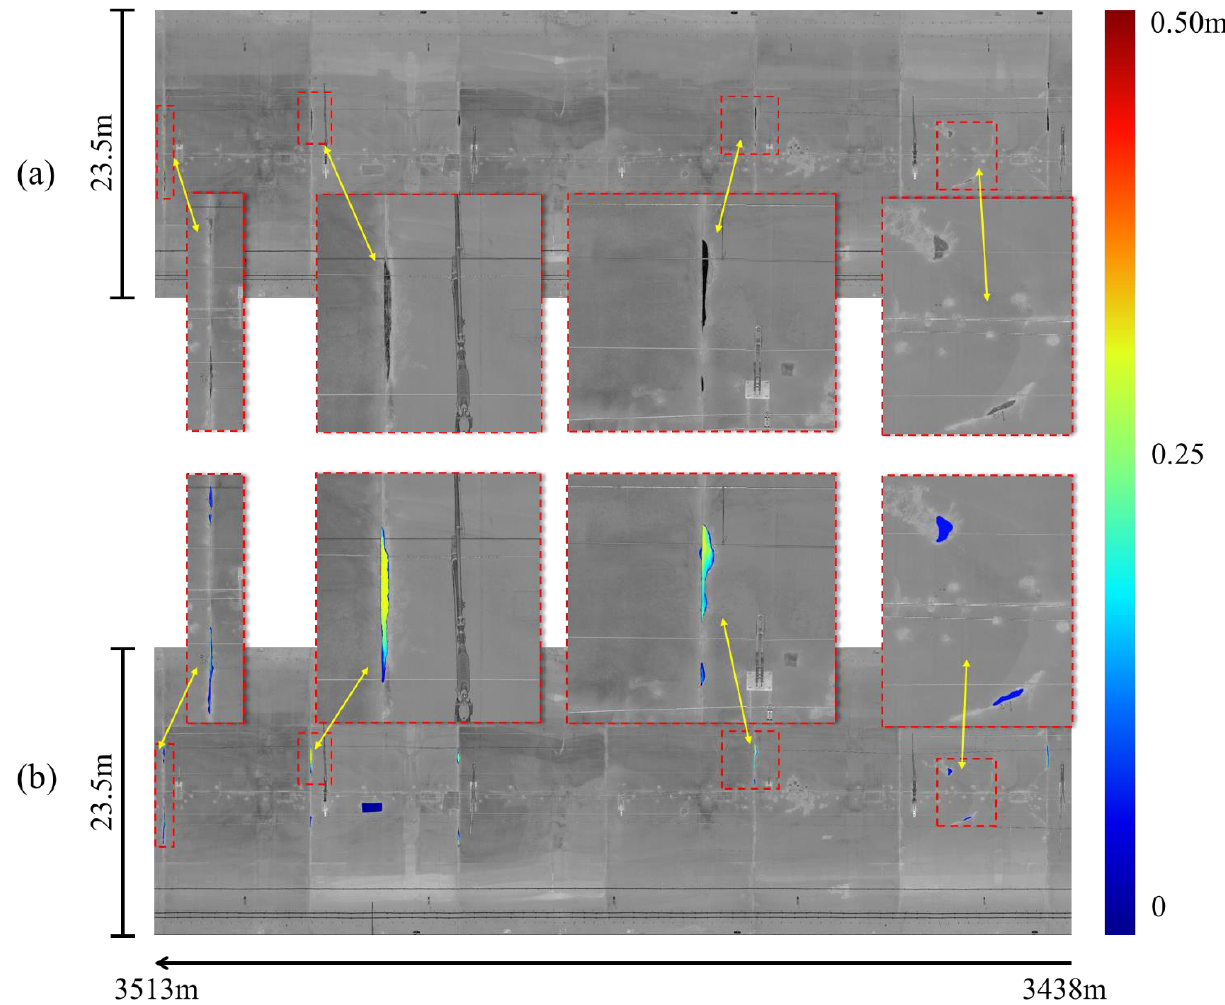
Figure 18. The comparison from a 75 m long tunnel section between ( a ) the stitched input intensity image and the enlarged local regions and ( b ) the inspection results output from the SIDNet model and the enlarged spalling defects regions (the depth value ranges from 0 (blue) to 0.5 m (red)).